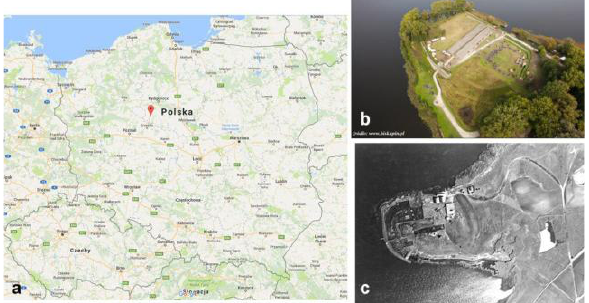
Figure 1: Location of Site 4 of the Lusatian culture fortified settlement in Biskupin: a) location on the map of Poland, b) current photographs of the site, c) pre-war photographs of the site.